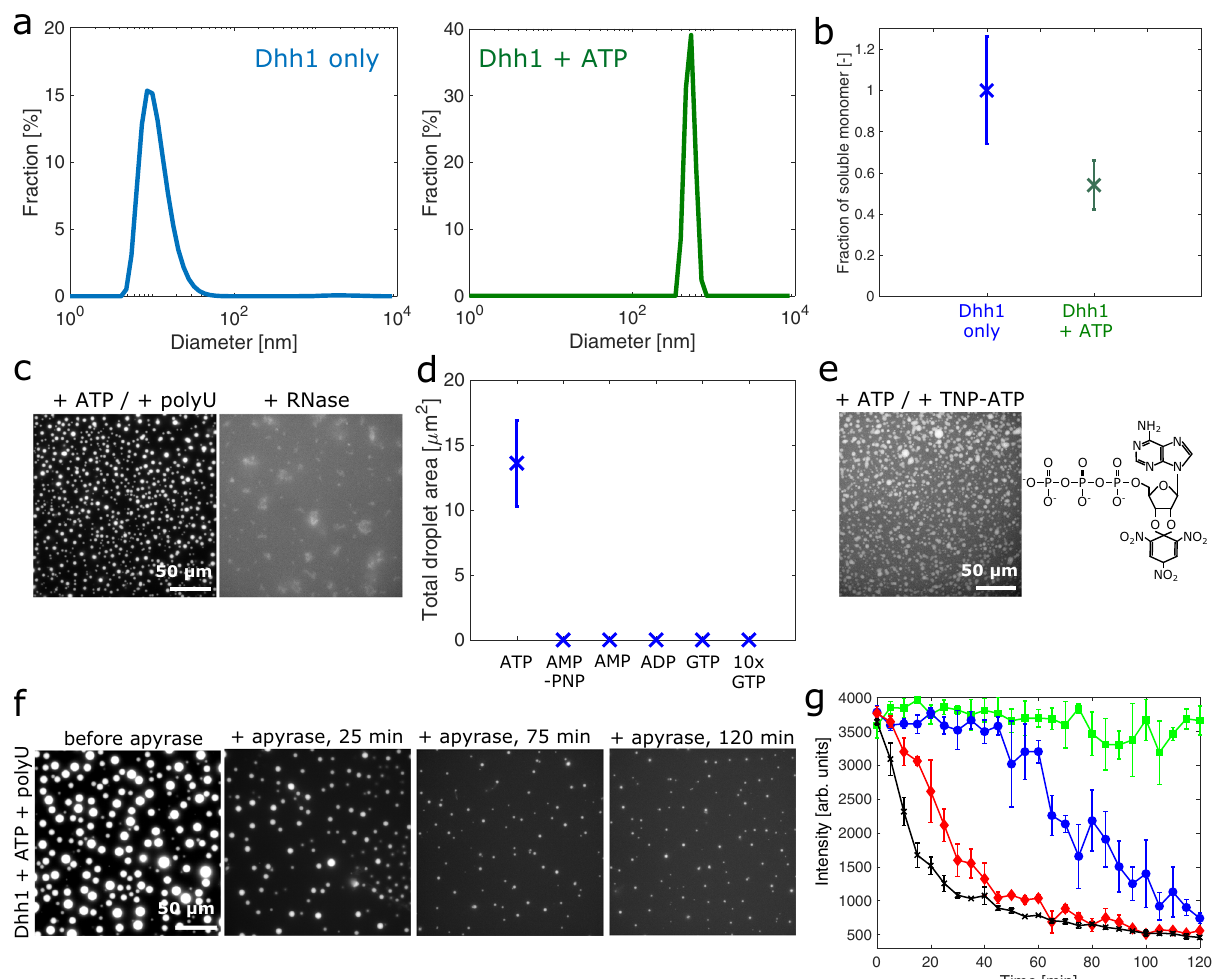
Fig. 2 ATP and RNA control the formation and dissolution of phase-separated Dhh1-rich droplets. a Size distributions measured by dynamic light scattering show the formation of condensates upon the addition of 5 mM ATP to a homogenous solution of Dhh1. b Upon ATP binding, the fraction of soluble Dhh1 monomer decreases to 55 ± 12% with respect to a homogenous Dhh1 solution. Error bars represent the standard deviation of three different samples. c Dhh1 droplets formed in the presence of ATP and polyU can be dissolved by adding 36 µ M RNase A, showing an additional level of regulation to form and dissolve the condensates. d Effect of ATP, AMP-PNP, ADP, AMP, and GTP on the phase separation of Dhh1 quanti fi ed by evaluating the mean droplet area at each condition. Error bars represent the standard deviation for >1000 individual droplets from three independent samples. e Fluorescence microscopy images of droplets in the presence of 2.5 mM ATP and 2.5 mM TNP-ATP, an ATP derivate that becomes fl uorescent when bound to an ATP binding site. f Fluorescence microscopy images showing the kinetics of droplet dissolution upon addition of 1.2 µ M apyrase. g Addition of 0 µ M (green), 0.6 µ M (blue), 1.2 µ M (red) and 2.4 µ M (black) of apyrase to droplets formed by 2 µ M Dhh1 in the presence of 5 mM ATP and 0.5 mg/ml polyU concentration-dependently dissolved the droplets. The panel depicts the mean total droplet fl uorescence intensity. Error bars represent the standard deviation of three different samples. Source data for panels a , b , d , g are provided in the Source Data fi